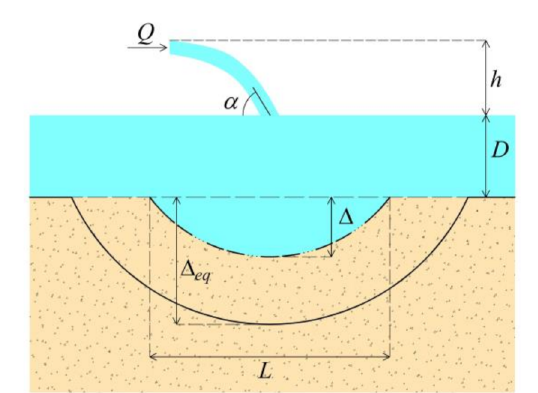
Figure 1. Diagram sketch of scour hole evolution, along with the main hydraulic and geometric parameters, with α indicating the impinging angle of the jet on the water surface with respect to a horizontal